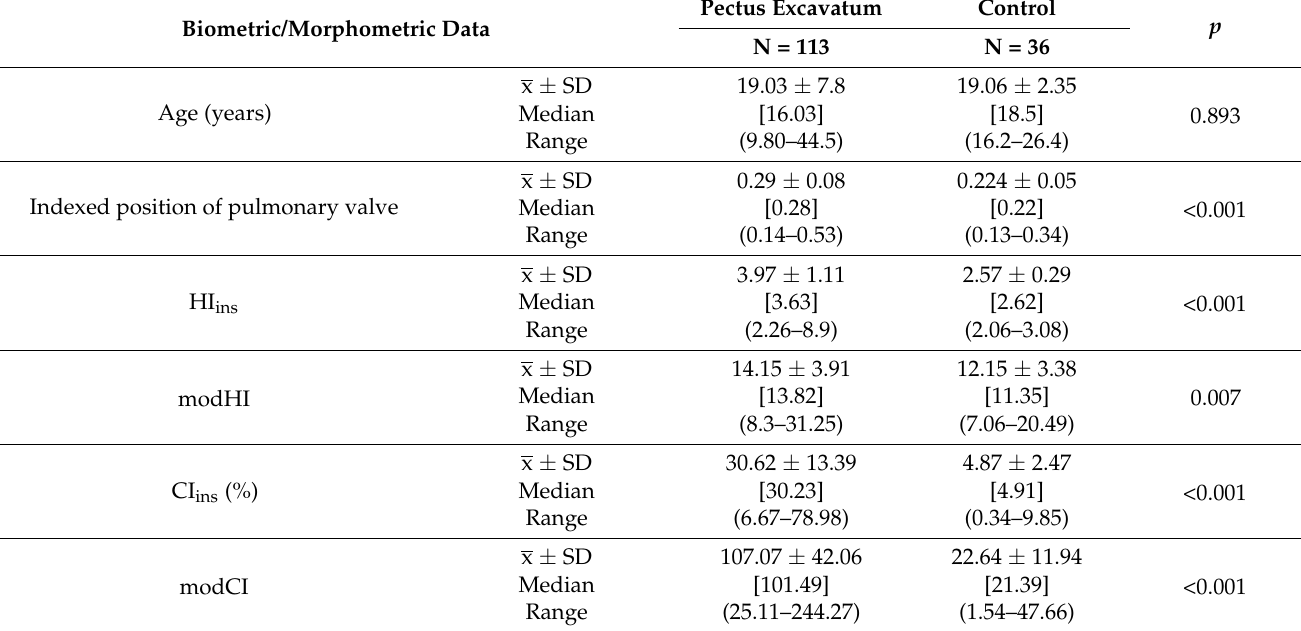
Table 1. Biometric and morphometric data according to pectus excavatum and control